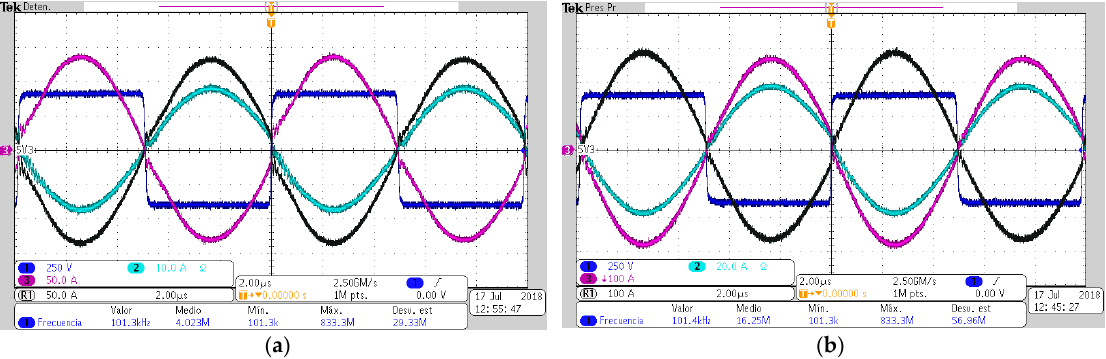
Figure 24. Experimental results: secondary transformer current (magenta and black), input resonant current (cyan), input voltage bridge (blue); ( a ) at 5 kW of output power; ( b ) at 10 kW of output power.